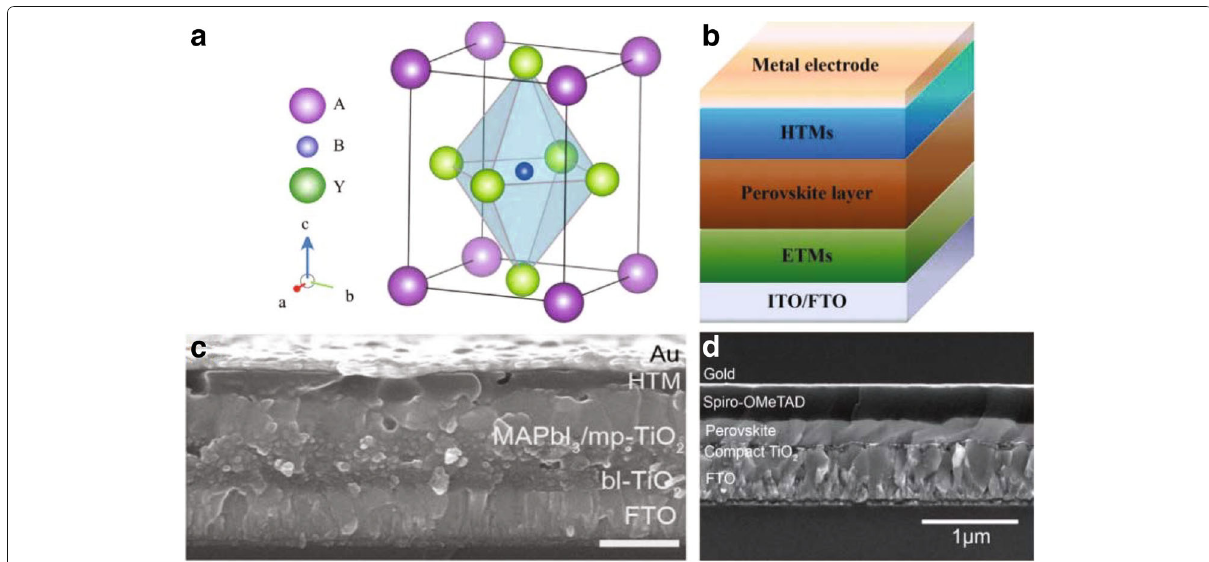
Fig. 2 a Crystal structure of a perovskite [22]. b Schematic diagram of general device [23]. c Cross-section scanning electron microscopy (SEM) images of a meso-superstructured perovskite solar cell ( scalebar is 500 nm) [22]. d Cross-section SEM images of a normal planar perovskite solar cells with the presence of an HTL and an ETL [22]